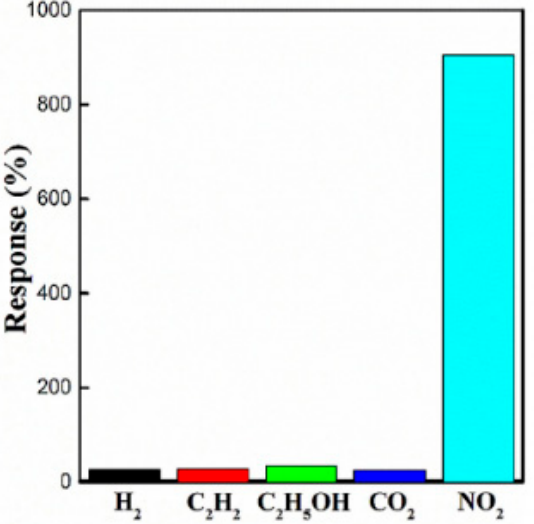
Figure 21. Response of heterojunction sensor to different analytes. Hydrogen (H 2 ), acetylene (C 2 H 2 ), ethanol (C 2 H 5 OH), carbon dioxide (CO 2 ), Nitrogen doxide (NO 2 ). Reproduced with permission from reference [89].